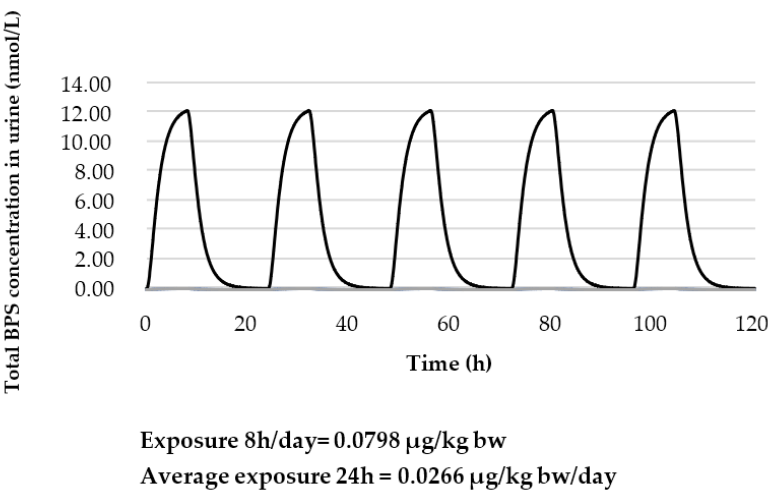
Figure 4. Estimated free BPS and glucuronidated BPS plasmatic concentrations (nmol/L) for an adult of 70 kg considering an occupational scenario lasting 5 days with daily exposure from 0 h to 8 h to 0.0798 µg/kg bw and from 8 h to 24 h to 0 µg/kg bw corresponding to an exposure for the entire day (0–24 h) of 0.0266 µg/kg bw/day.